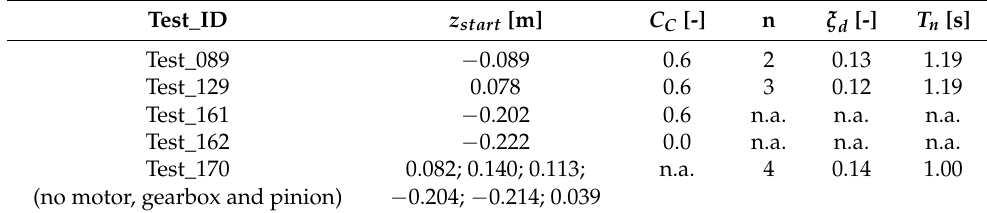
Table 7. Overview of the performed free decay